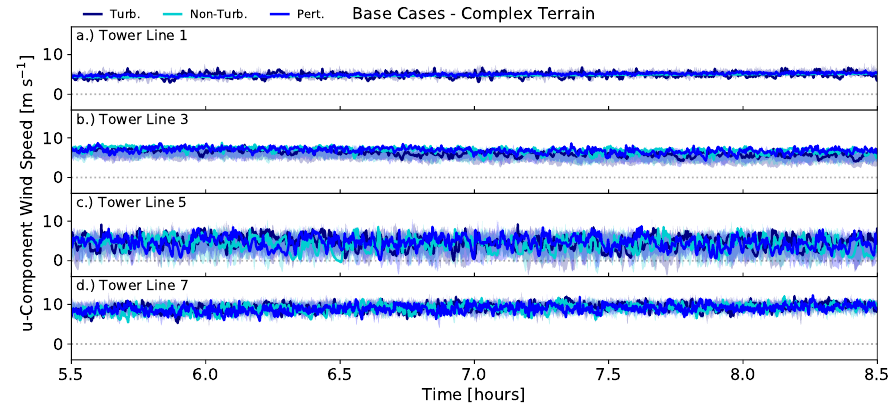
Figure 5. Time series of the u -component wind speed at y , z = 10.0,110 m for tower lines 1, 3, 5, and 7 (see Figure 2) in panels ( a – d ), respectively, in the CXT_base cases. Shaded in the background are the ranges of values across the tower lines.